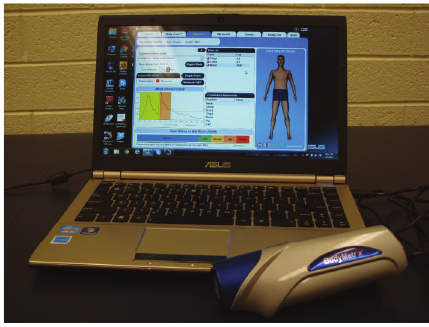
Figure 4: BodyMetrix ultrasound with body composition software.